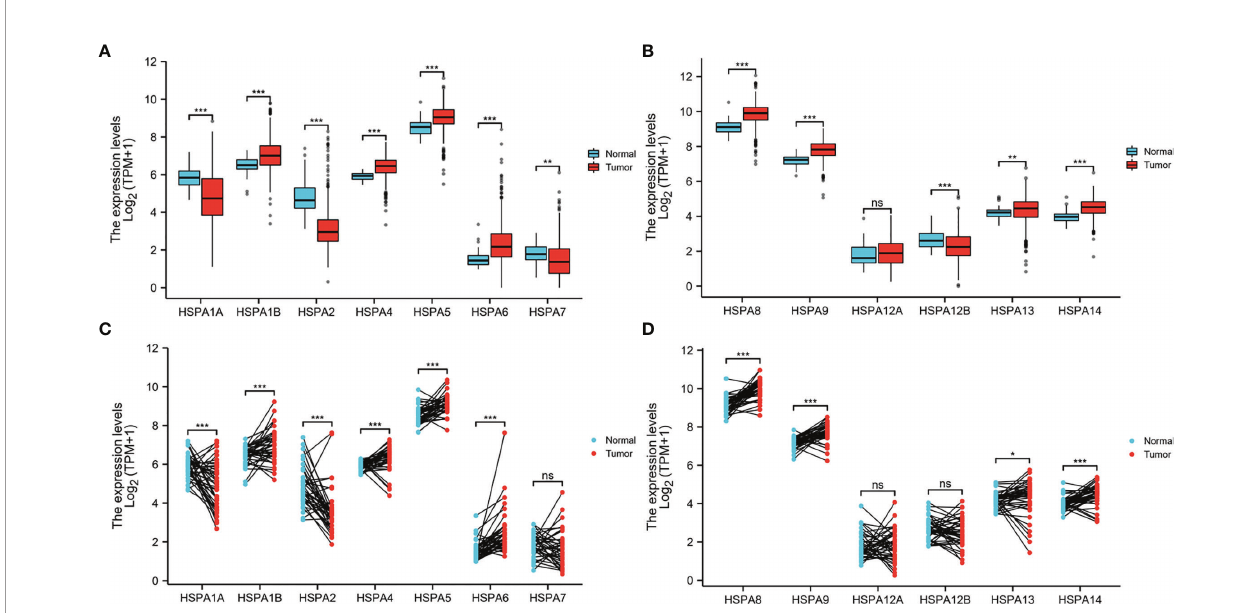
FIGURE 1 | Differential expression of HSPA family members in colon cancer and normal tissues. (A) HSPA1A, HSPA1B, HSPA2, HSPA4, HSPA5, HSPA6, and HSPA7 expression in colon cancer and normal tissues by unpaired comparison. (B) HSPA8, HSPA9, HSPA12A, HSPA12B, HSPA13, and HSPA14 expression in colon cancer and normal tissues by unpaired comparison. (C) HSPA1A, HSPA1B, HSPA2, HSPA4, HSPA5, HSPA6, and HSPA7 expression in colon cancer and normal tissues by paired comparison. (D) HSPA8, HSPA9, HSPA12A, HSPA12B, HSPA13, and HSPA14 expression in colon cancer and normal tissues by paired comparison (Wilcoxon rank-sum test for unpaired comparisons and Wilcoxon signed-rank test for paired comparisons. ns, non signi fi cant; * P < 0.05; ** P < 0.01; *** P <